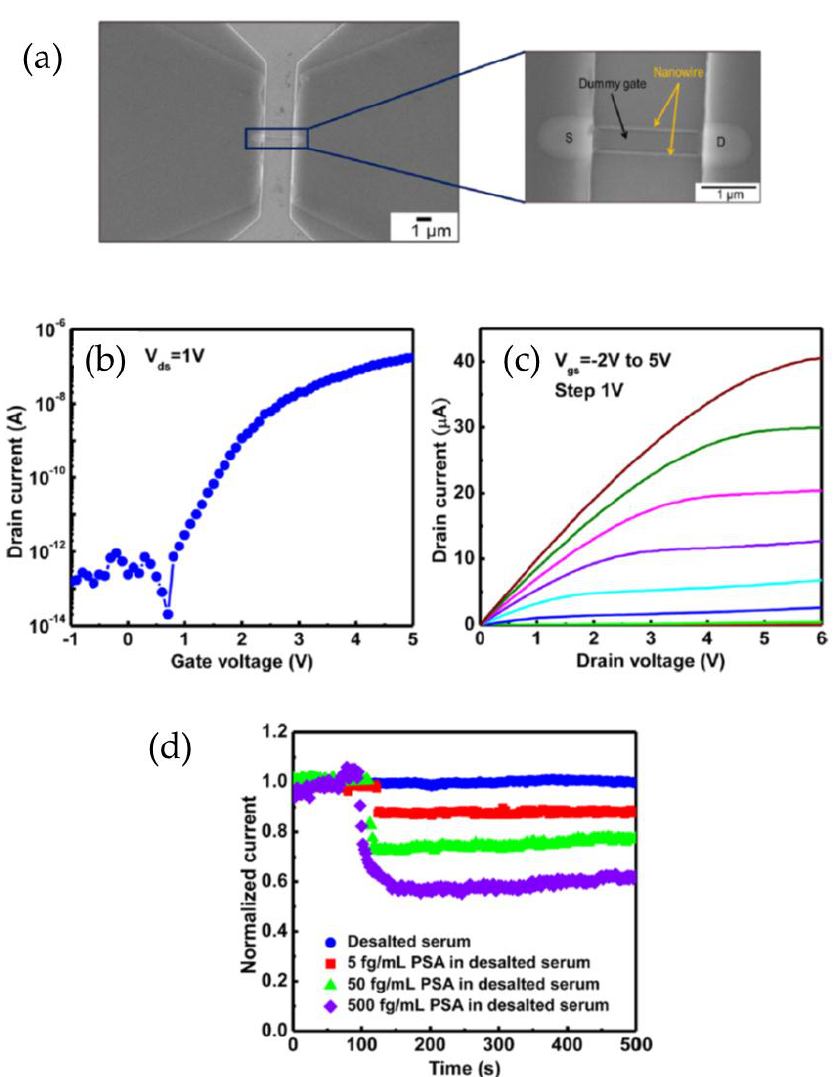
Figure 3. n-type SiNW-based FET immunosensor for detection of PSA biomarker. ( a ) SEM images of a SiNW-FET sensor; ( b ) Electrical characteristics (I DS × V G curves) of the SiNW-FET device; ( c ) Output characteristics (I DS × V DS curves) showing a dependence on the controlled V G ; ( d ) Normalized current × time for SiNW devices to detect various PSA concentrations in desalted human serum. No electrical response was observed for serum without PSA. Reprinted with permission from Huang et al. [48].